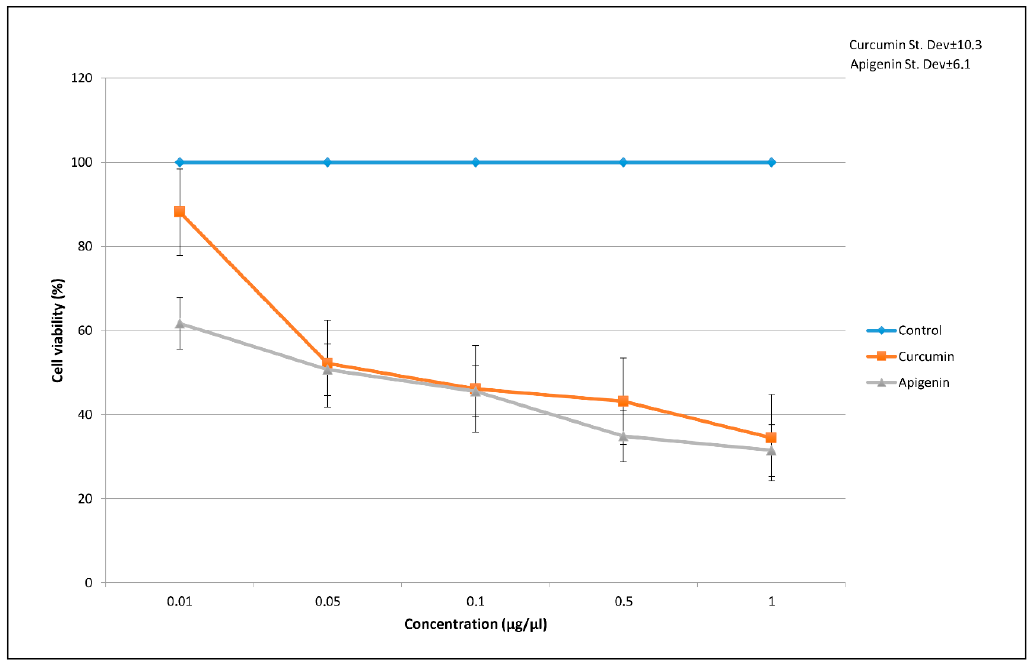
Figure 1. Cell viability of the HeLa cells depending on drug